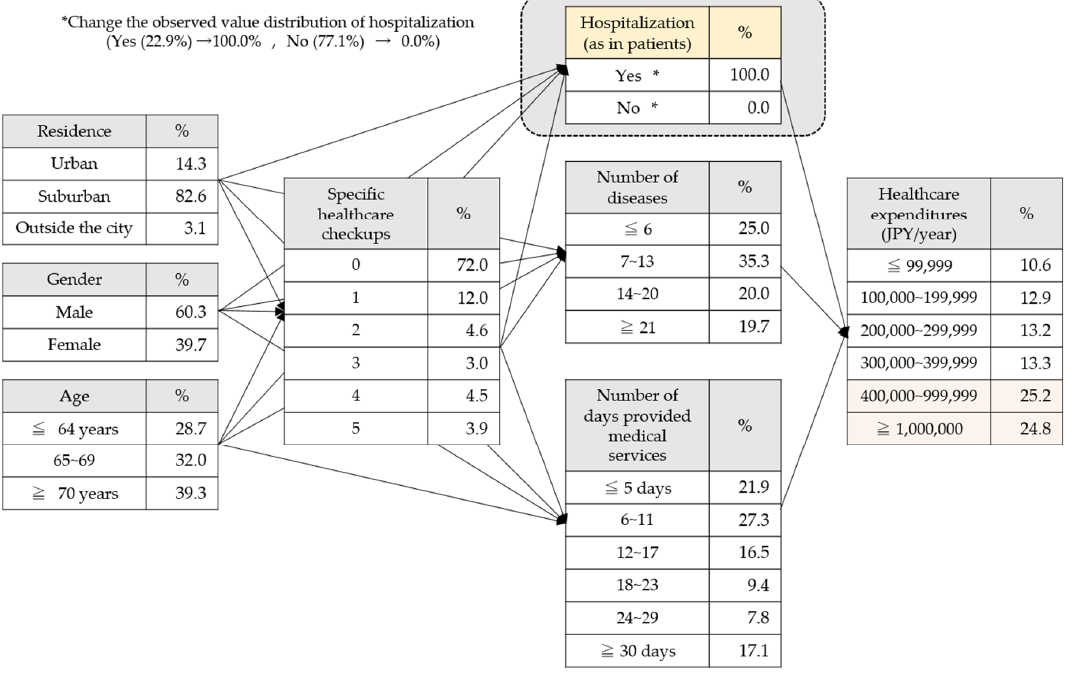
Figure 2. Hypothetical model in which everyone was hospitalized.